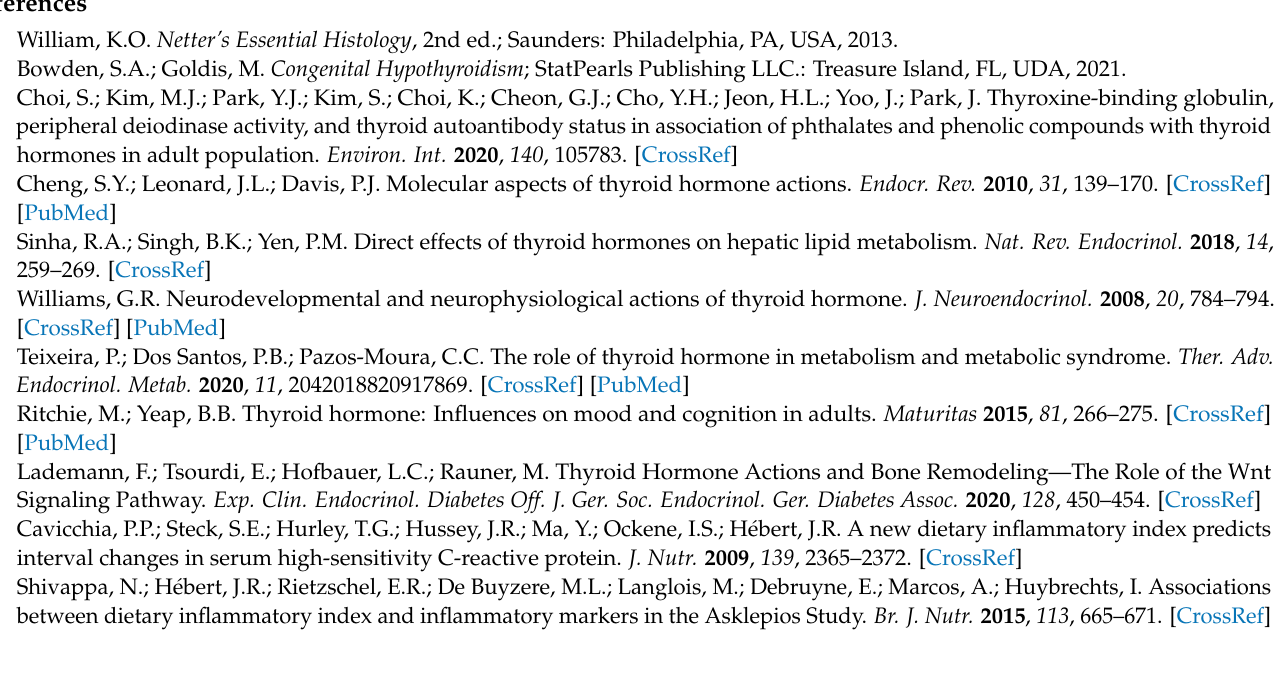
Table S1: Baseline characteristics of participants based on DII tertiles, weighted. Table S2: The methodology of dietary inflammatory index